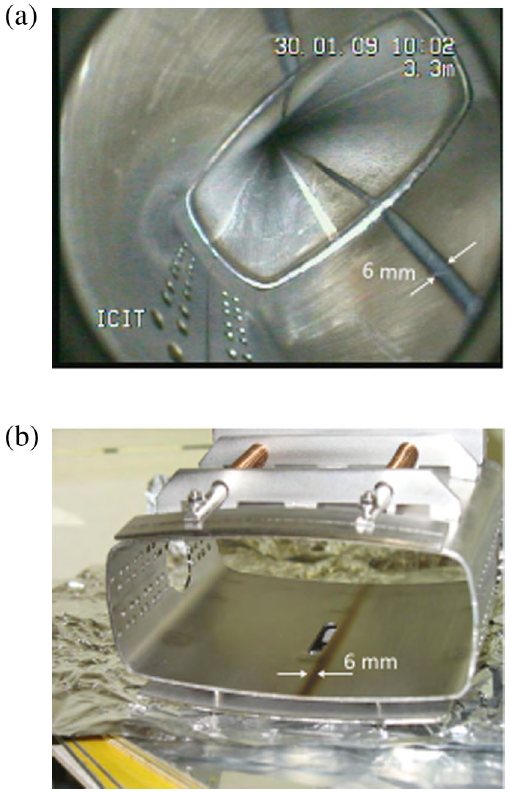
FIG. 10. Thin dark traces along the beam axis in the vacuum chamber of dipole (a) and in the rf shield between dipoles